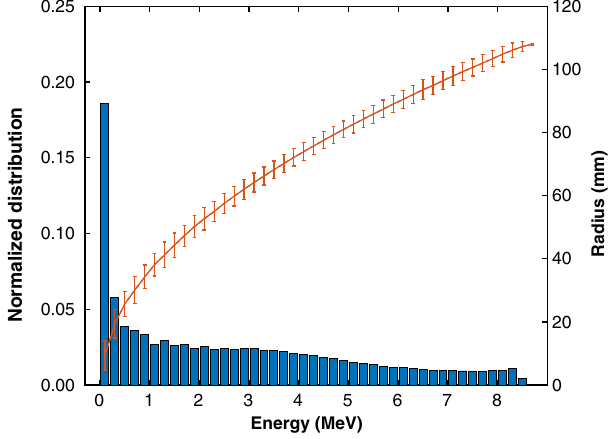
FIG. 5. Histogram of normalized energy distribution of the losses. The normalization is over the total amount of stripping losses. Solid orange line with error bars represents the radial location of particles corresponding to each histogram bin asso-